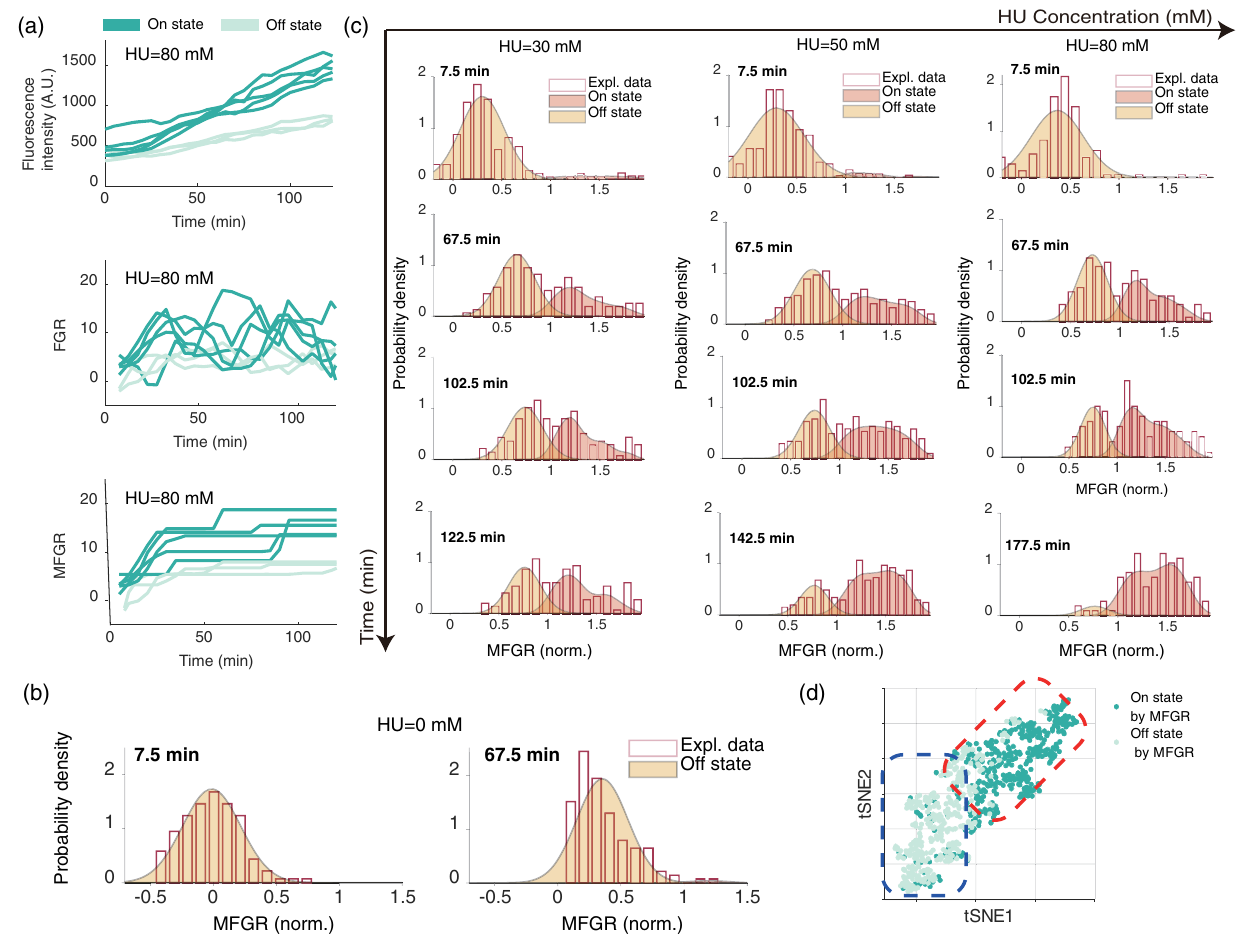
MFGR (norm.) FIG. 2. Time series and analysis by the maximum value of fluorescence growth rate (MFGR) of Rnr3 protein and t-SNE plots for the original data, revealing the bimodal distribution of cellular states, corresponding to the inactivation/off and activation/on states of the S- phase checkpoint in yeast WT strain. (a) Some typical fluorescence time series in yeast cells under HU ¼ 80 mM (top) and their corresponding fluorescence growth rates FGR ð t Þ (middle) and MFGR ð t Þ (bottom). Each trajectory represents the data from one individual cell, and its color represents the activation state, as determined from the bimodal distribution in Fig. 2(c). The time is initialized for each cell, starting from its first budding time. (b) Probability density distribution without HU treatment. It should be noted that the cells that have negative values at time 7.5 min will increase to positive values at time 67.5 min, owing to the fluctuation of FGR, which does not mean the activation of these cells. (c) Probability density distribution of yeast WT strains for 30, 50, and 80-mM HU concentrations at various times. Compared with the control group (without HU treatment, HU ¼ 0 mM), The HU-treated groups evolve towards the bimodal distribution from the initial unimodal distribution, suggesting the existence of two different responsive states to the DNA replication stress signal. The off-state cells are fitted with Gaussian distribution based on the data (light yellow area), and on-state cells are fitted with kernel distribution (dark yellow area). (d) Raw data of the Rnr3 GFP time series with various HU doses (30, 50, and 80 mM), processed by the t-SNE dimensionality reduction method. The dark green points represent the activation state determined from Fig. 2(c). The low-dimension manifold of the time series can be clustered into two groups (marked by red dashed circles), corresponding to off and on states,